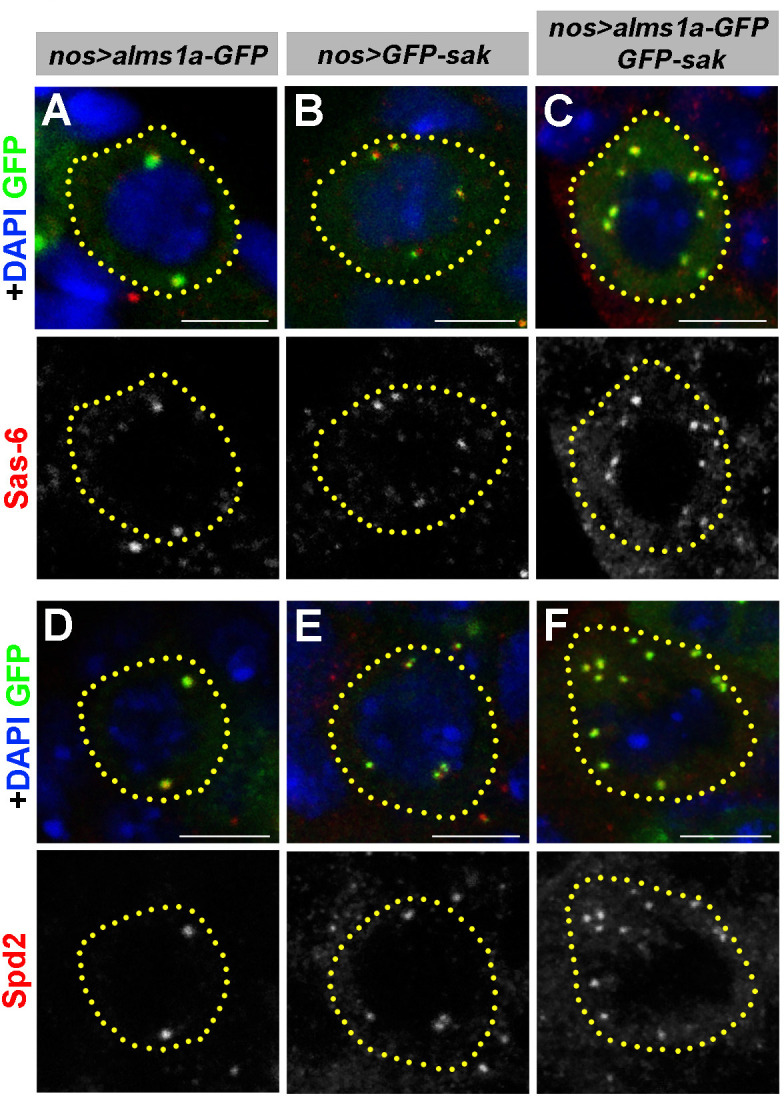
Alms1a overexpression enhances centrosome overduplication induced by Sak overexpression.(A–C) Examples of Sas-6 staining in nos-gal4>UAS-alms1a-GFP (A), nos-gal4>UAS-GFP-sak (B) and nos-gal4>UAS-alms1a-GFP, UAS-GFP-sak (C) germ cells. Flies were raised at 25°C to drive a higher level of protein expression. Green: GFP. Red: Sas-6. Blue: DAPI. (D–F) Examples of in nos-gal4>UAS-alms1a-GFP (D), nos-gal4>UAS-GFP-sak (E) and nos-gal4>UAS-alms1a-GFP, UAS-GFP-sak (F) germ cells. Flies were raised at 25°C to drive a higher level of protein expression. Green: GFP. Red: Spd2. Blue: DAPI. Germ cells are outlined with yellow dotted lines. Bar: 5 μm.